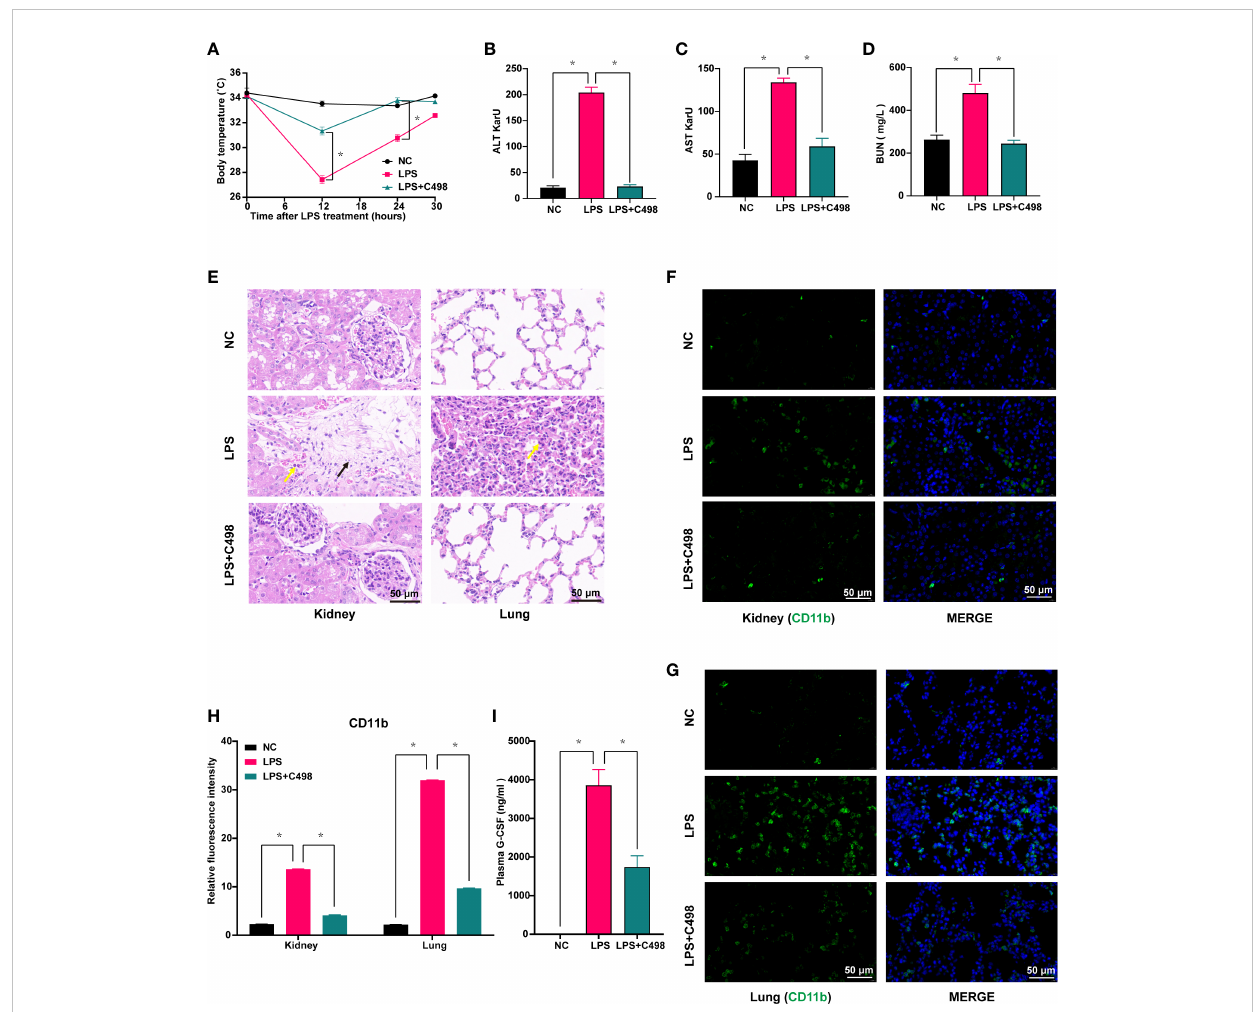
FIGURE 5 C498 prevents temperature loss and tissue damage caused by LPS-induced septic shock in vivo. Mice were i.p. administrated with 5 mg/kg C498 12 h before the LPS challenge (6 mg/kg, i.p.). Body temperature (A) was recorded. Mice treated as in (A) were sacri fi ced 24 h after LPS injection and plasma ALT (B) , AST (C) , and BUN levels (D) were measured. Mice treated as in (A) were sacri fi ced 12 h after LPS injection and HE staining (100 ×) of in fl ammatory cell in fi ltration in the lung and kidney (E) . Yellow arrows indicate neutrophil in fi ltration and black arrows indicate nuclei fragmentation. Mice treated as in (A) were sacri fi ced 12 h after LPS injection. Immuno fl uorescence (F, G) and relative fl uorescence intensity (100 ×) of kidney and lung (H) . The green color indicates CD11b staining and blue indicates nuclear DAPI staining (F-H) . (I) The detection of 24 h plasma G-CSF levels by ELISA assay. *P < 0.05 is considered signi fi